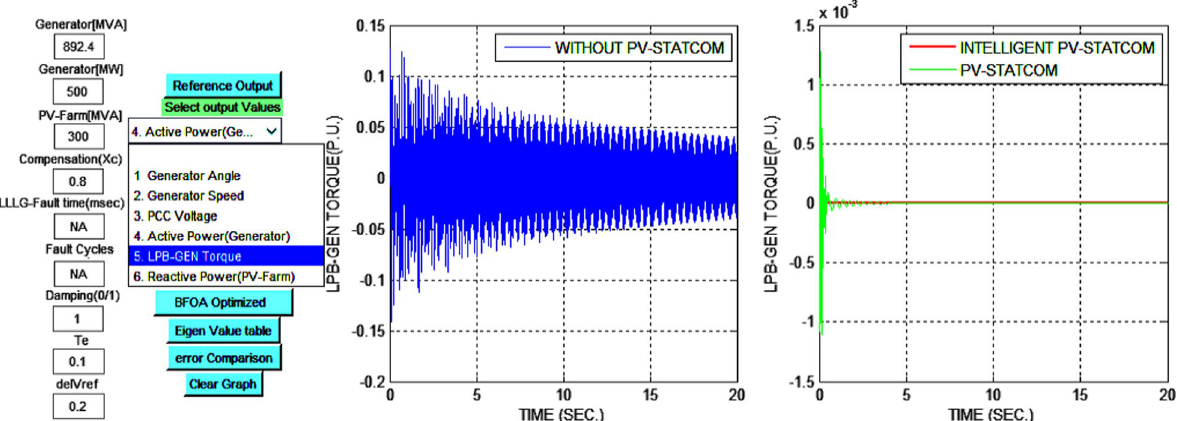
Fig. 20 Torsional deviations ( �τ Lp